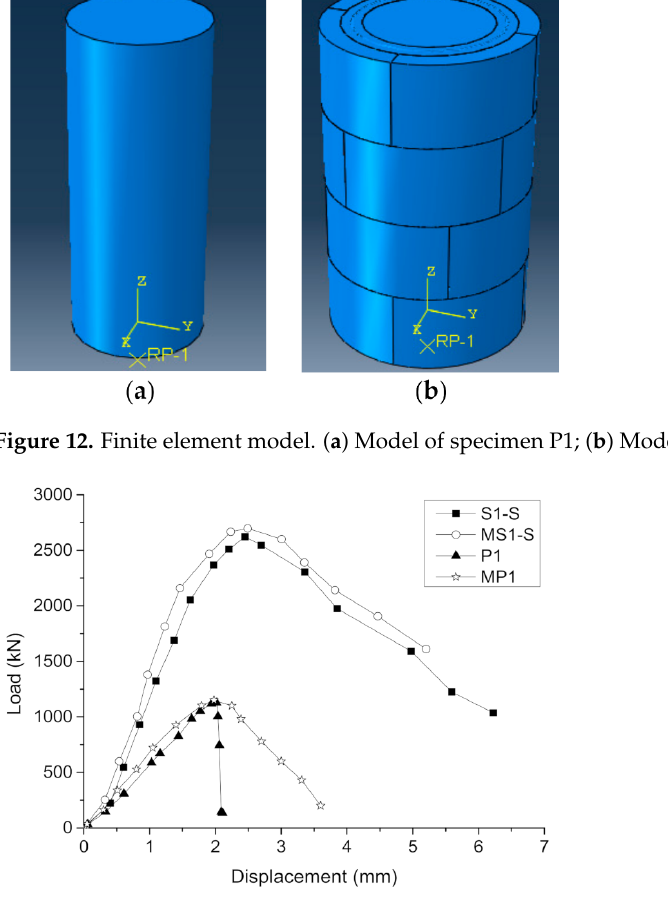
Figure 13. Load–displacement curves of specimens acquired using the numerical model and